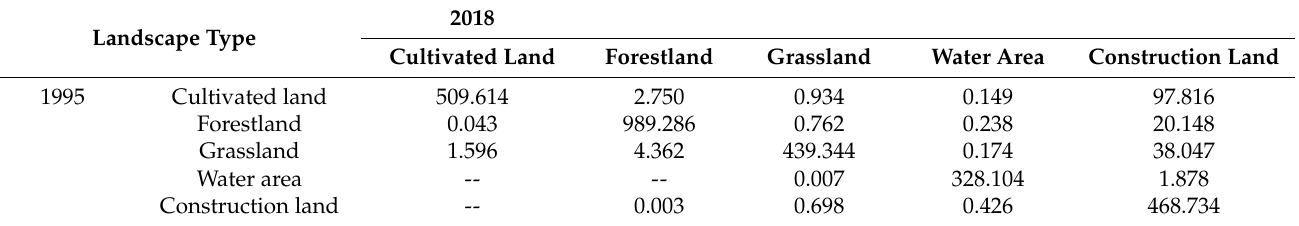
Table 1. Transfer matrix for land use in Dianchi Lake basin of China in 1995–2018 (unit: km 2 ). Landscape Type